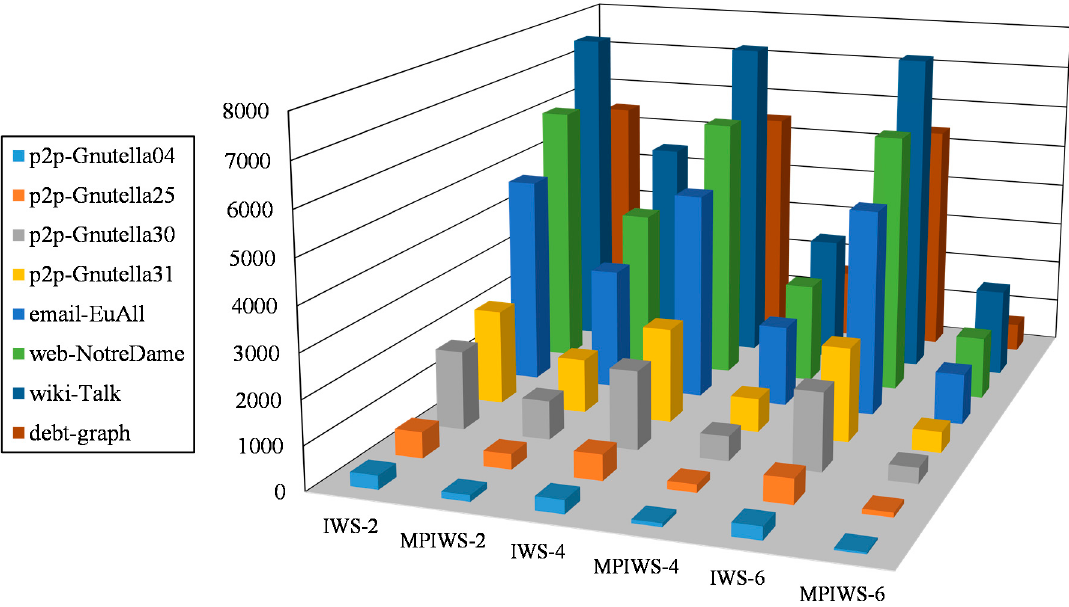
Figure 9 . Execution time of different algorithms on different CPU.